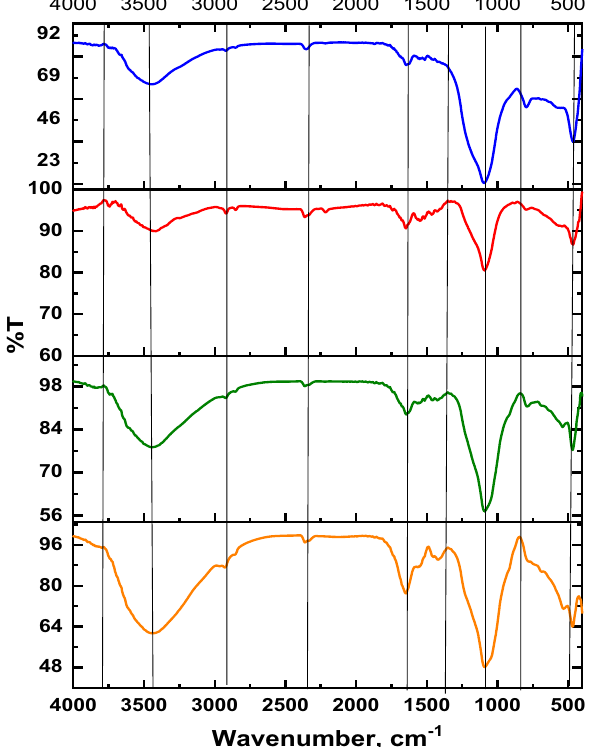
Fig. 2 FT-IR of the AS400 powder Fig. 3 TEM micrograph of the AS400